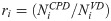
Illustrative risk model, ri.Histograms and Gaussian distribution functions of feature fi = height for all CPD cases (shaded histogram bars and solid line NCPD) and all uncomplicated vaginal delivery cases (blue histogram bars and dashed line NVD) and ri=(NiCPD/NiVD) from Eq (2)2 is shown in the dotted line. Note that the histograms and distribution functions refer to the vertical axis to the left and ri refers to the vertical axis to the right.